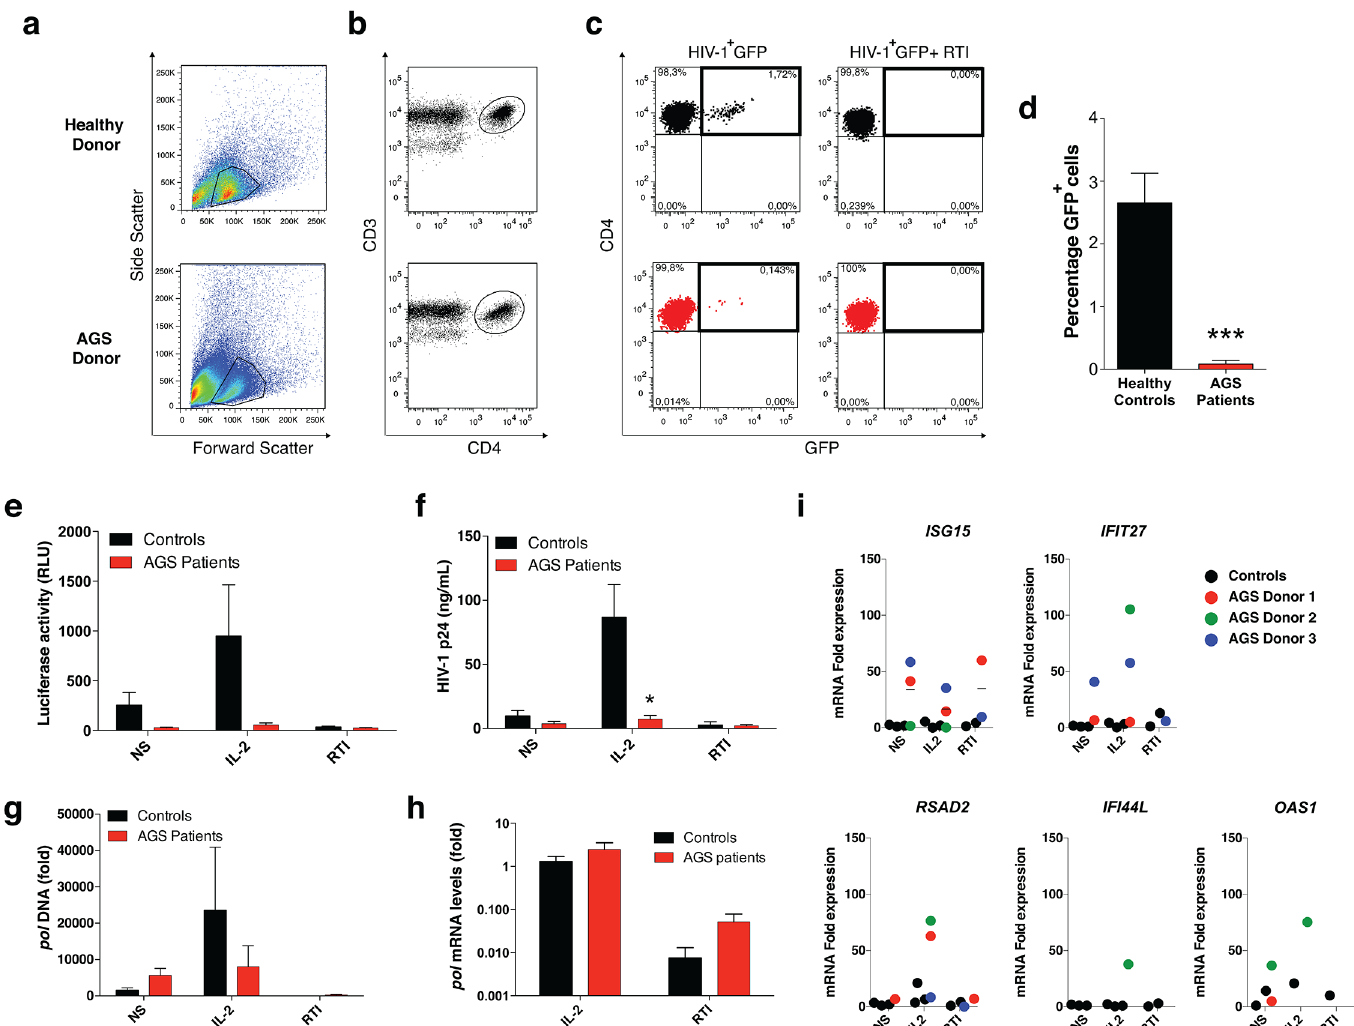
Fig 1. ADAR1 deficiency restricts HIV-1 replication in activated human CD4+ T cells. (a-b) PBMCs from healthy donors (n = 4) and ADAR1-mutated patients (n = 3) were challenged with equivalent infectious units of HIV-1 GFP virus and analyzed on day 5 after infection. The reverse transcriptase inhibitor (RTI) cocktail (10 μ M AZT, 20 μ M DDI, and 10 μ M 3TC) was used as specificity control. (a) Representative dot plots of flow cytometry analysis from PBMCS of an AGS patient and a healthy control. The viable cells (gate, left graphs) were stained and selected for CD3+CD4+ expression (b). The percentages of infected (GFP+) CD4+ T cells (c) are shown in the upper right quadrant. (d) Bar graph representing the mean ± s.e.m. of GFP+ infected cells (n = 3), *** P < 0.001. (e) Bars represent luciferase activity in relative luciferase units (RLU) of cells infected with a VSV-G virus. The activity was measured in non- stimulated (NS), IL-2-stimulated or RTI-treated cells. Bars represent mean ± s.e.m (n = 3). (f) Bar graphs represent mean ± s.d (n = 3) of HIV-1 p24 protein amounts released into the cell culture supernatant on day 5 after infection, * P < 0.05. Relative quantification of viral DNA pol (g) and viral pol mRNA (h) expressed as fold versus NS control cells. (i) Relative quantification of ISG15, IFIT27, RSAD2, IFIT44L, and OAS1 from HIV-1-infected PBMCs from AGS patients (n = 3) and healthy donors (n = 3) presented as fold over NS control expression.